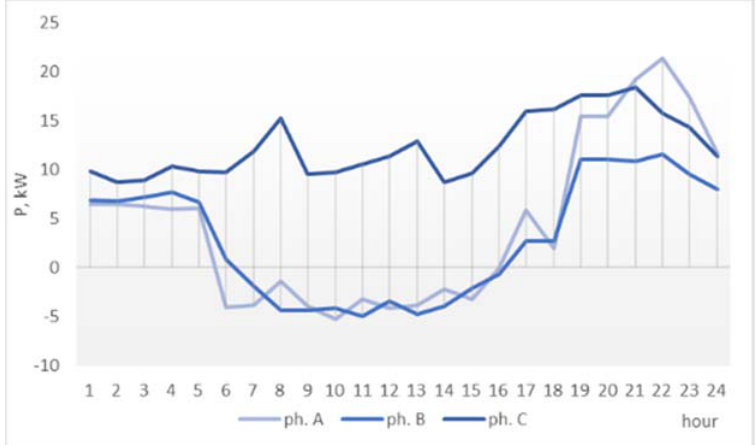
Figure 9. Actual bus demand in network R28 (aggregated demand and generation).